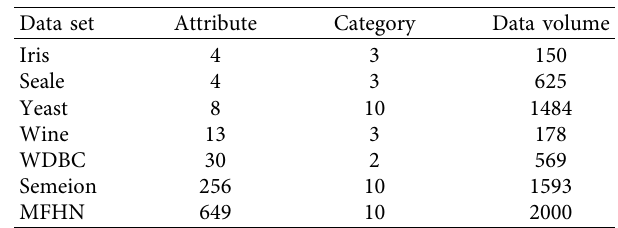
Table 2: 7 real data